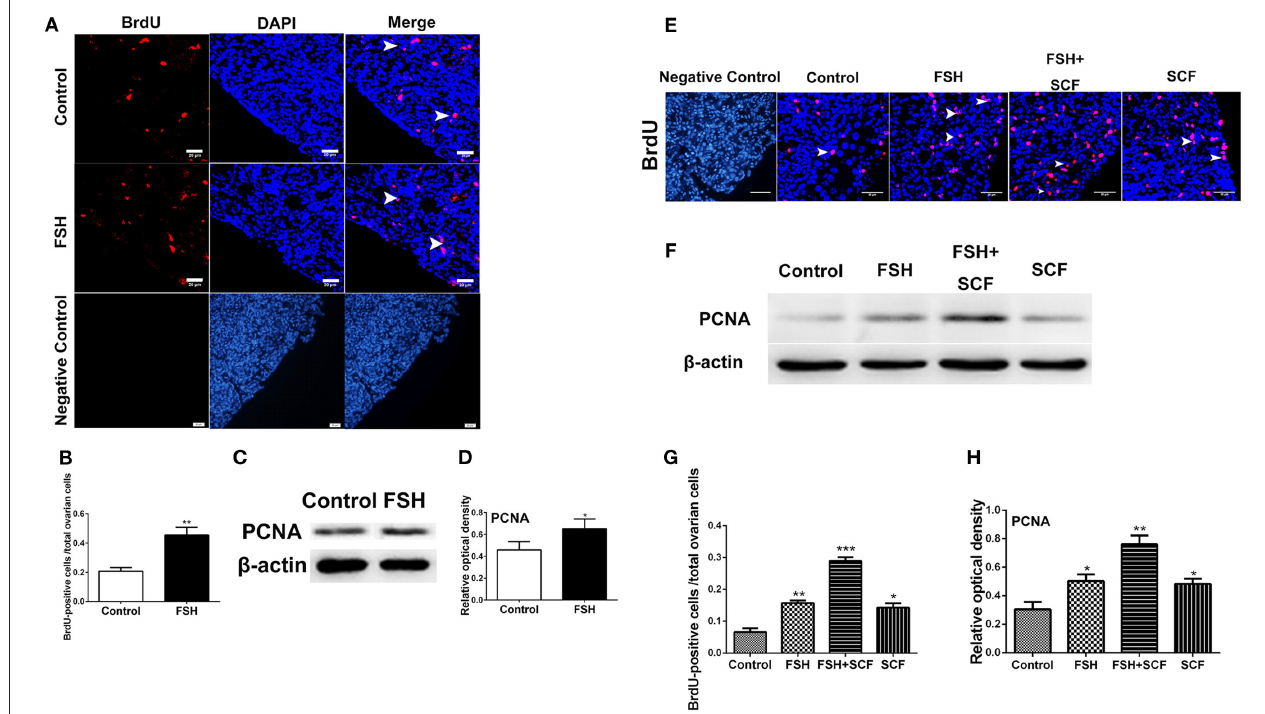
FIGURE 9 | Combined effects of FSH and SCF on cell proliferation. (A) The 6th day chicken ovaries were incubated for 6h with BrdU after treatment by FSH in vivo . Arrowheads represent ovarian cells with BrdU (red) marker in the ovarian cortex. DAPI (blue) represents the nuclear DNA. Scale bar: 20 µ m. (B) The percentage of BrdU positive cells increased significantly after FSH treatment. (C,D) Western blot and gray analysis indicate that FSH promoted PCNA protein expression. (E) 4-day-old chicken ovaries were treated by FSH or SCF in vitro for 3 days. Arrowheads represent the cells with BrdU (red) marker. DAPI (blue) represents nuclear DNA. Scale bar: 30 µ m. (G) The percentage of BrdU positive cells increased significantly with FSH and SCF treatment in combination. (F,H) SCF enhanced the effect of FSH to promote the PCNA protein expression. T -tests were used to determine statistically significant differences. The values are the mean ± SEM of six experiments. Asterisks indicate significant differences (* P < 0.05, ** P < 0.01, *** P <